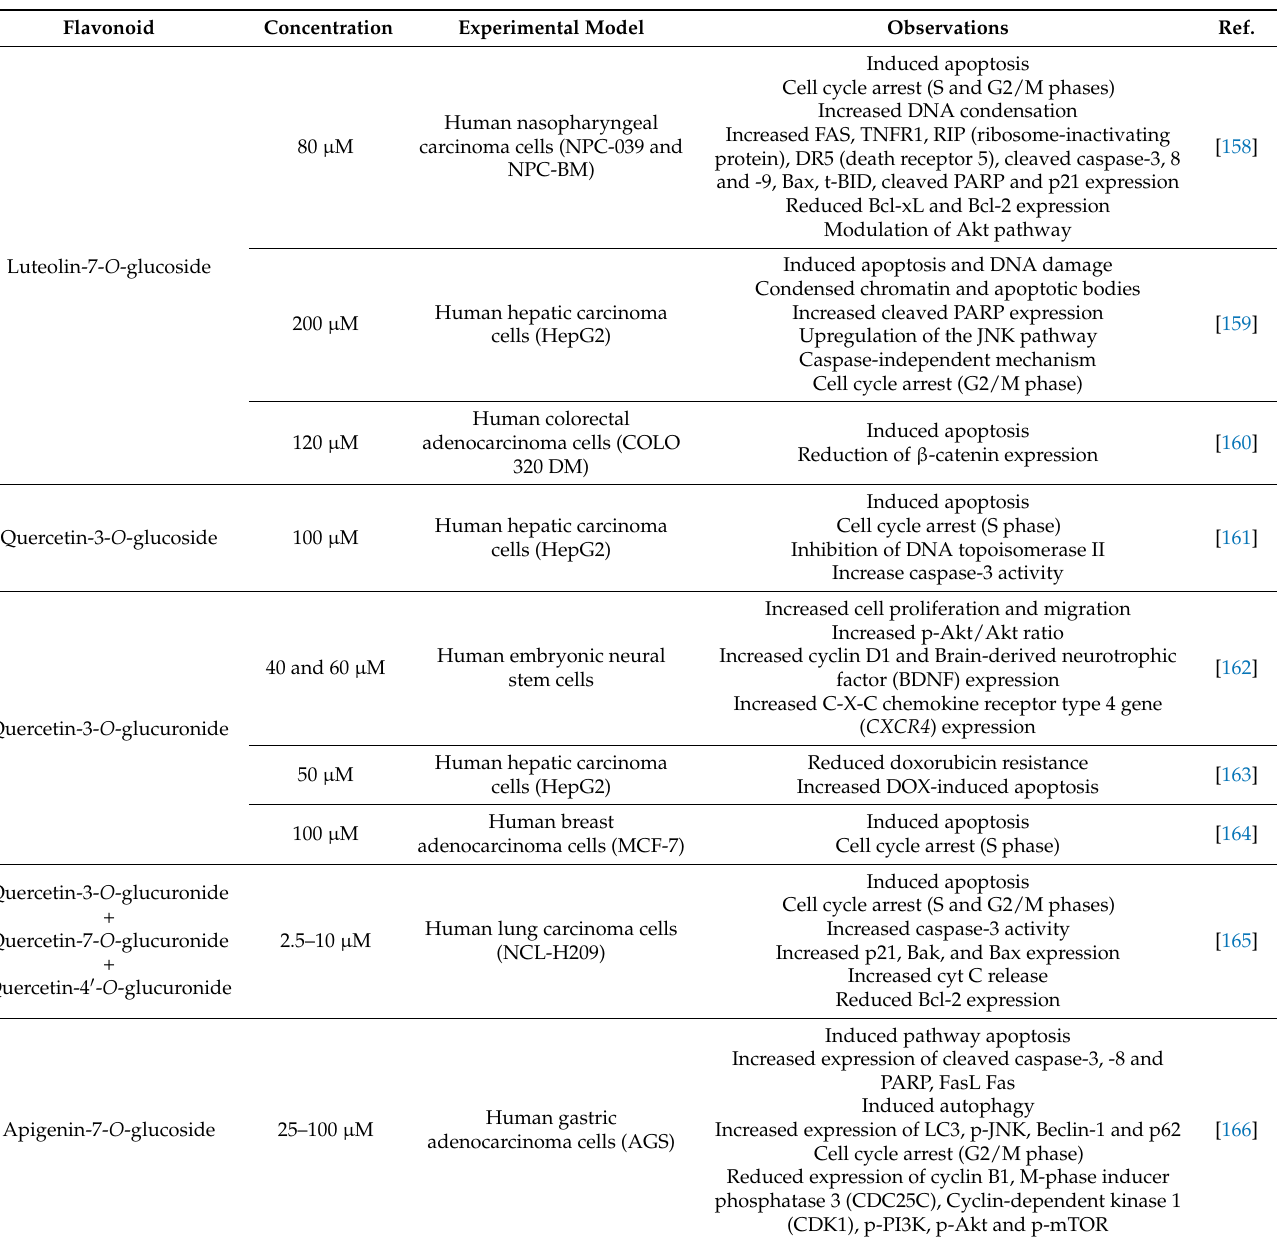
Table 4. Cell death pathways modulation by common flavonoid derivatives found in Thymus spp. extracts using in vitro and in vivo animal experimental